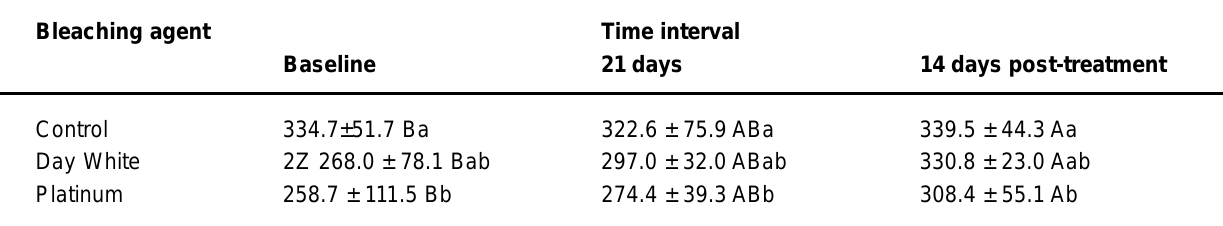
TABLE 2- Number and percentage of SEM images with erosions on enamel surface, according to values of visual evaluation mode, with respect to different treatments